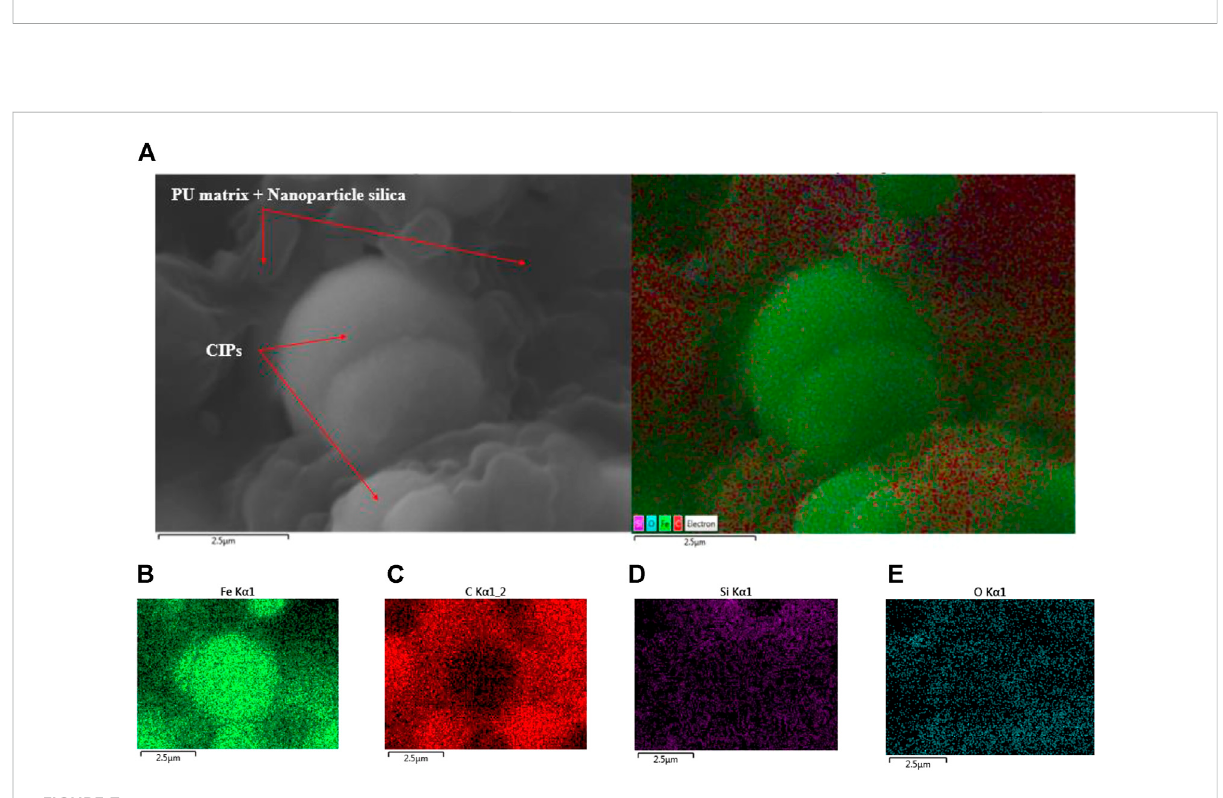
FIGURE 7 Mappinganalysisof (A) MRfoamwithadditionofsilicananoparticlesandrespectiveelementsof (B) iron,Fe; (C) carbon,C; (D) silicon,Si;and (E) oxide,